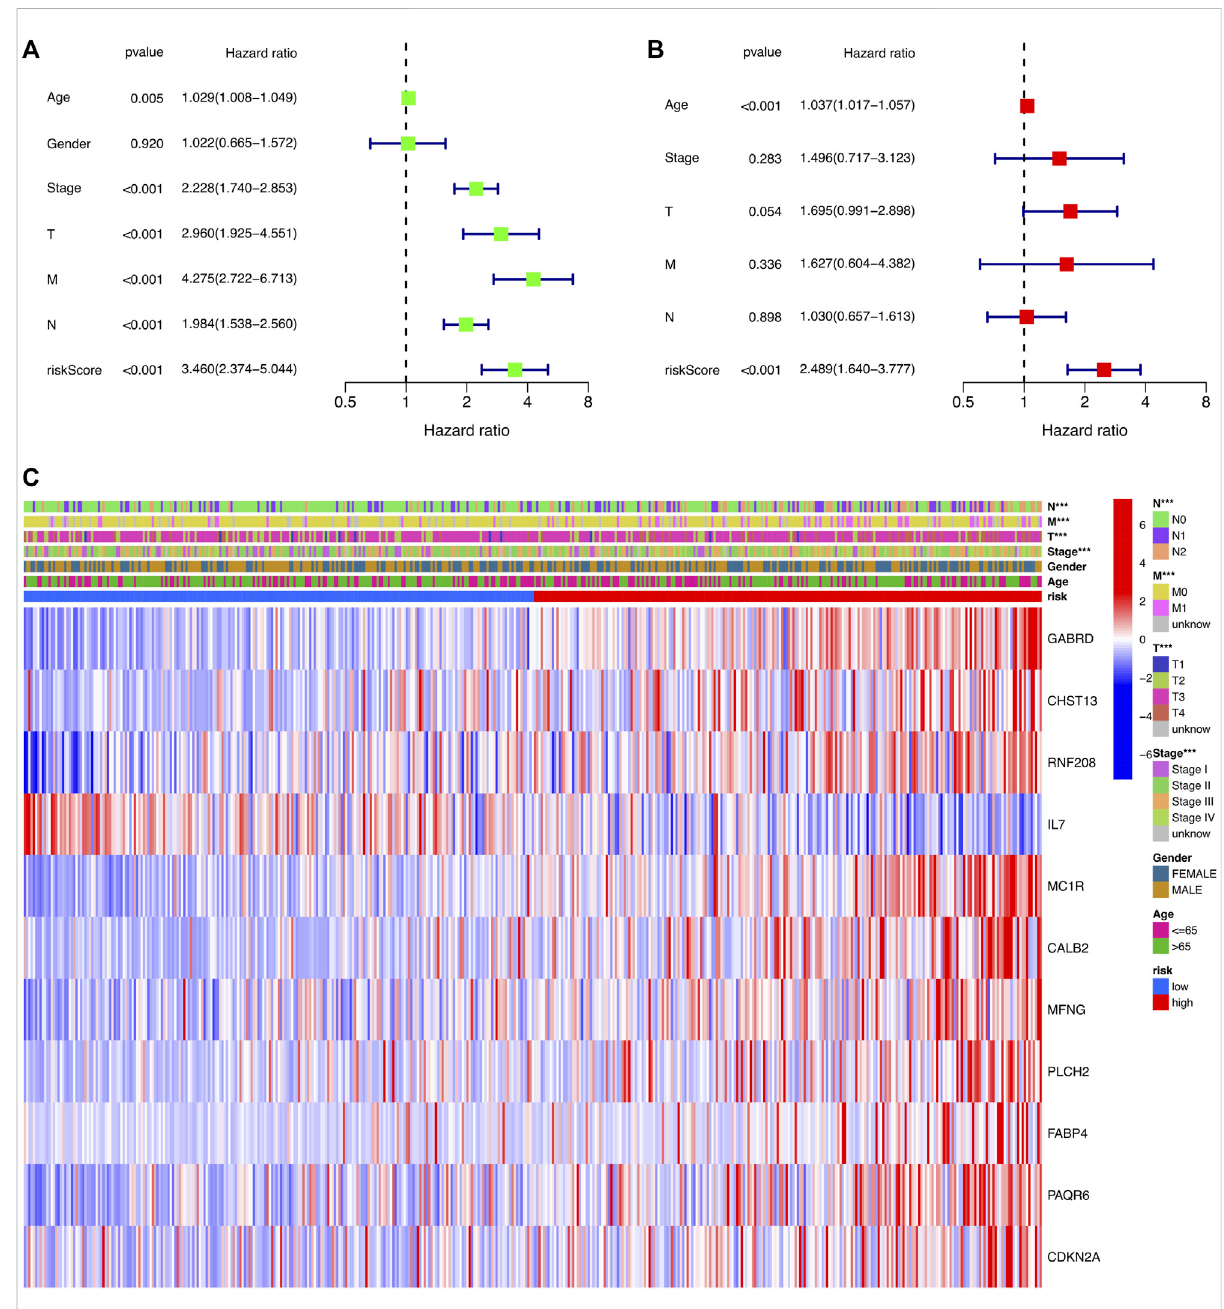
FIGURE 5 Independentprognosticanalysis oftherisksignature. (A) Univariate analysisfortheTCGA-COADcohort. (B) MultivariateanalysisfortheTCGA- COAD cohort. (C) Heatmap exhibiting the correlation of clinical characteristics and the risk